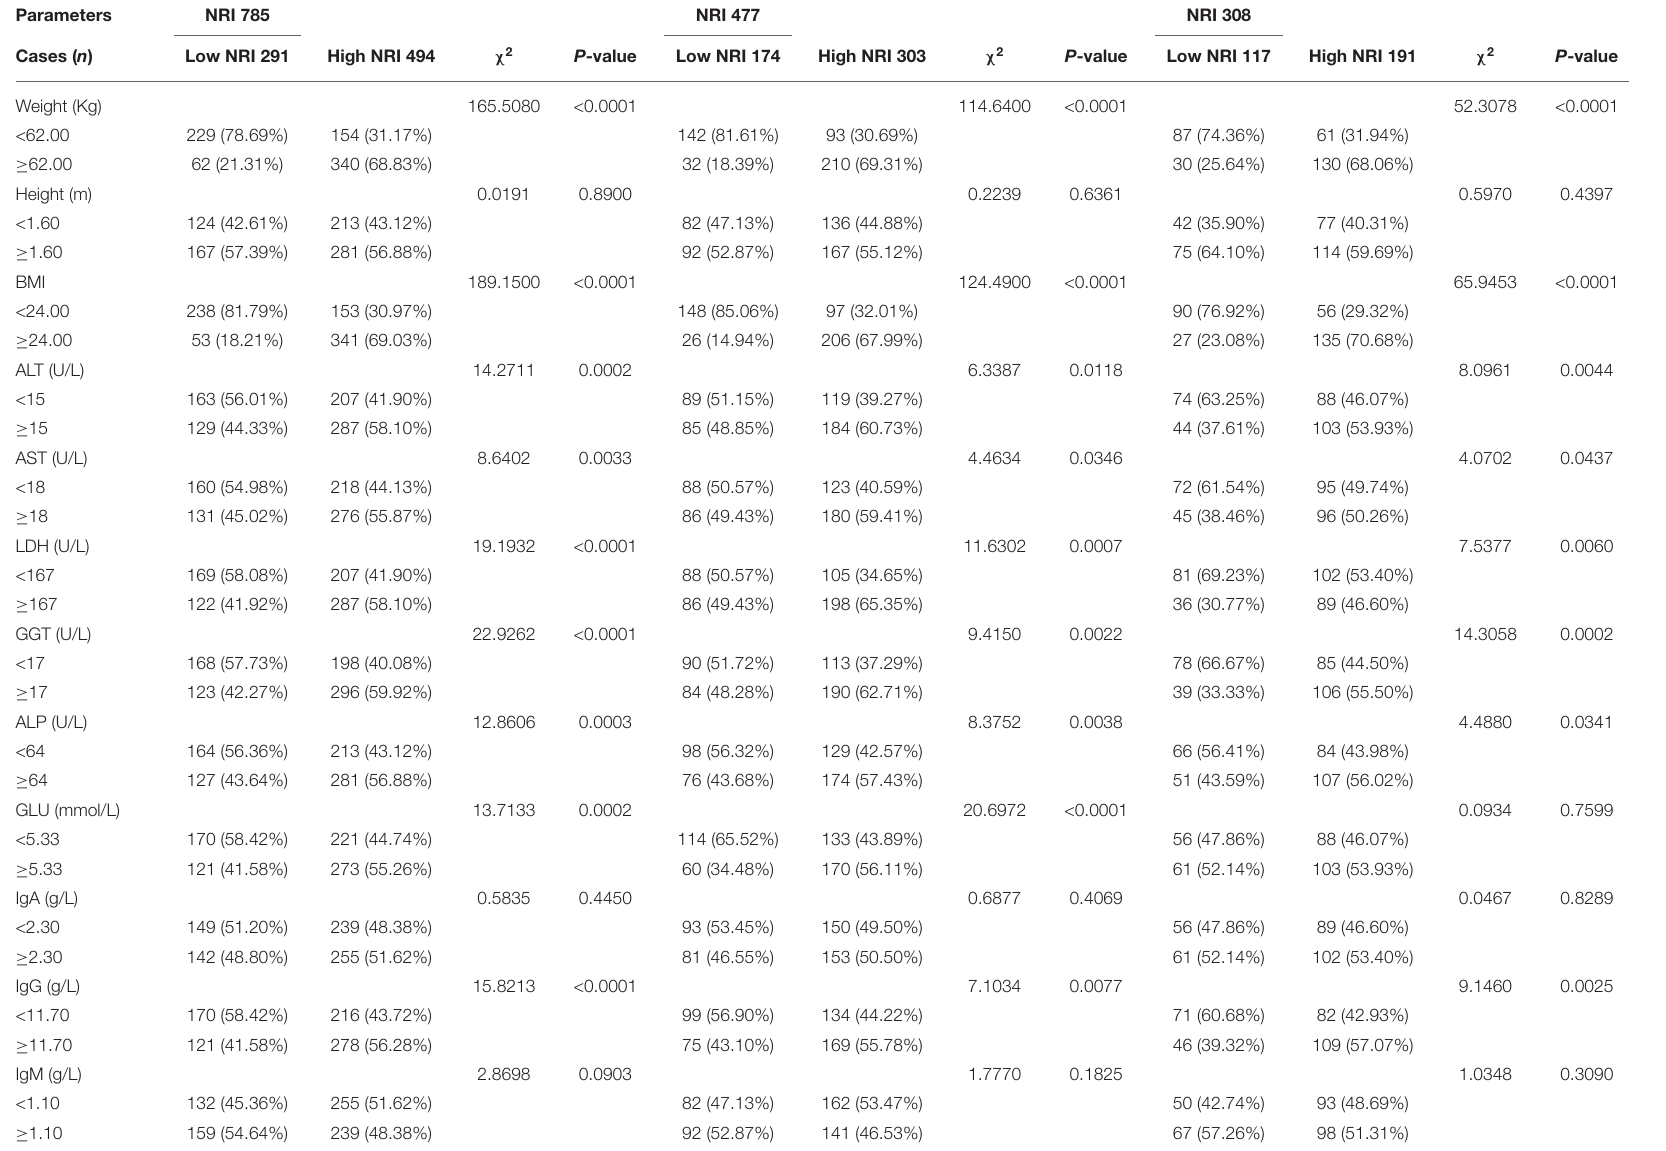
TABLE 2 | The correlation between nutritional parameters/blood parameters and